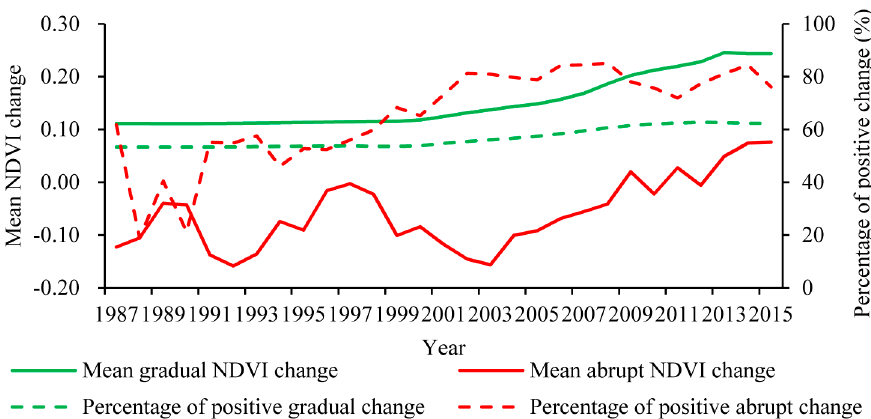
Figure 10. Annual mean and percentage of positive gradual and abrupt NDVI changes at Hangzhou Bay in Zhejiang Province, China.